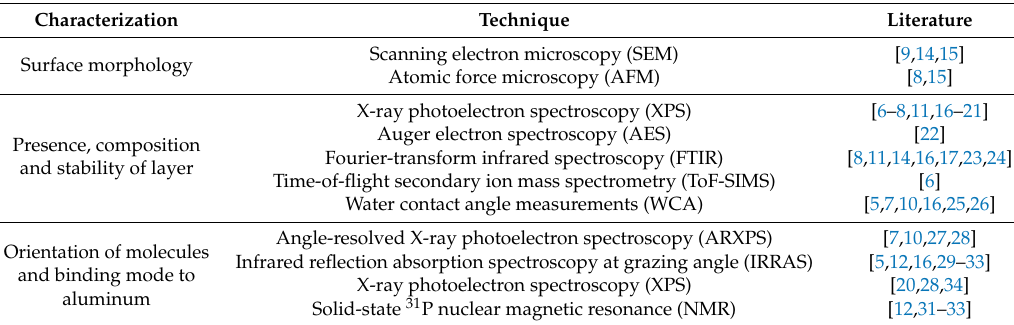
Table 1. Commonly-employed surface characterization